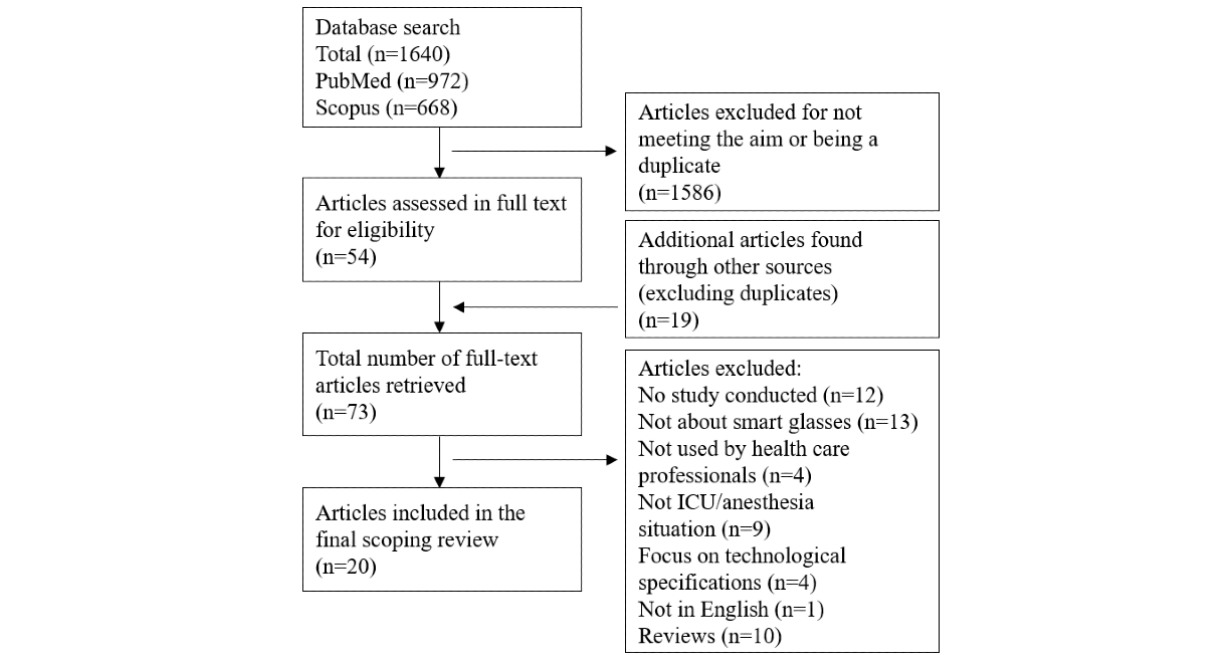
Figure 1. Flowchart of